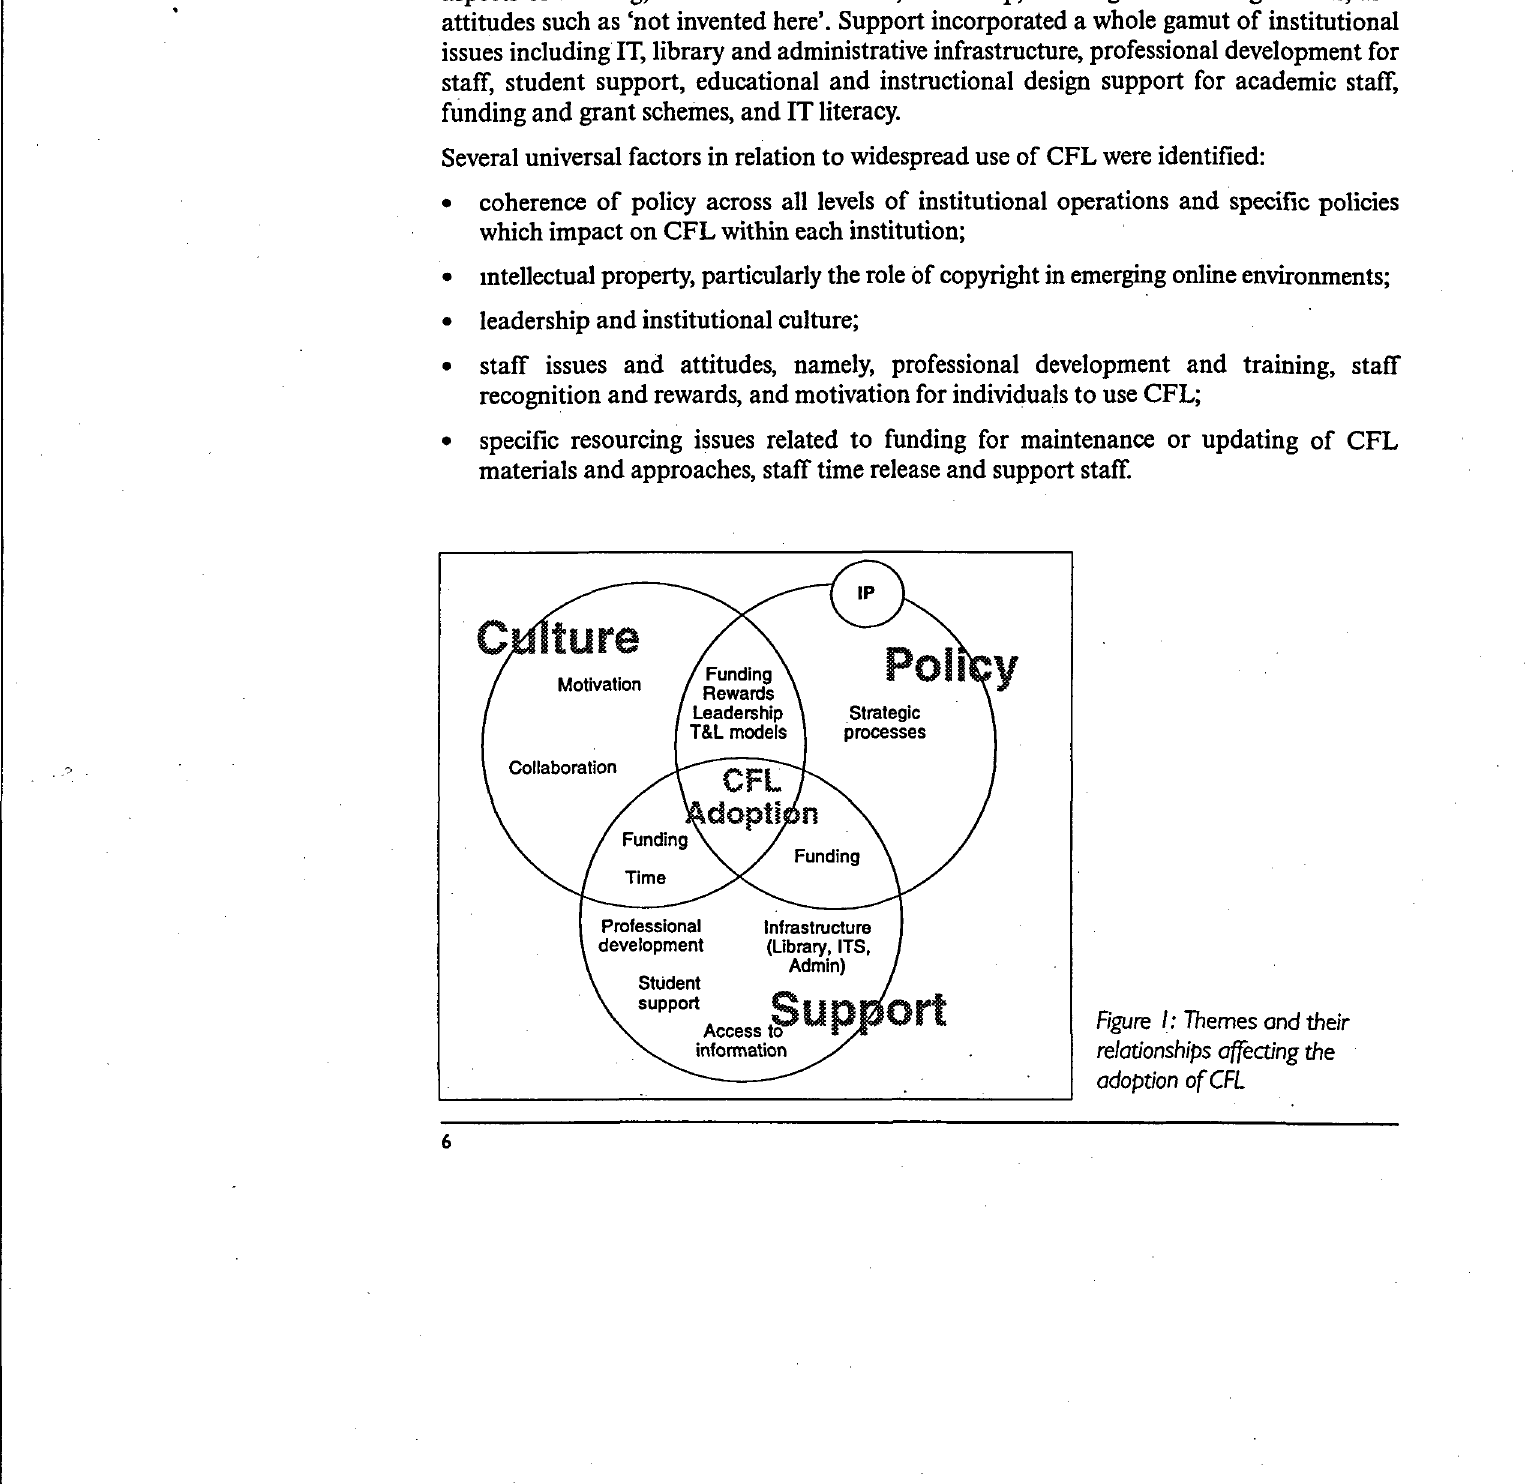
Figure I: Themes and their relationships affecting the adoption of